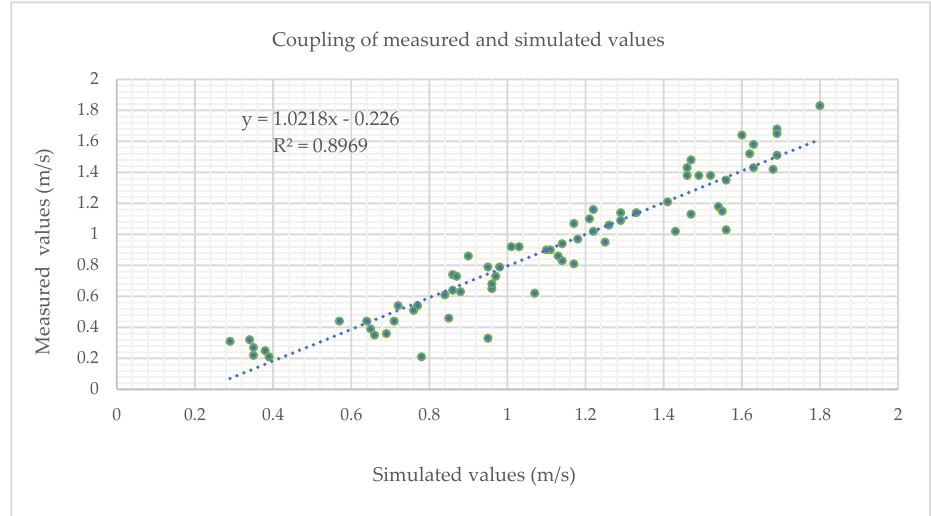
Figure 12. Linear regression plot of the values of the measured points and CFD simulation points. The data for the graph were obtained through CFD simulations.